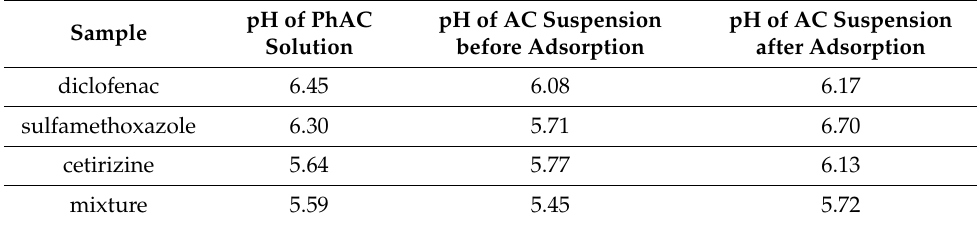
Table 2. pH values of PhACs solutions before and after adsorption using WSCl2. SD = ± 2%.